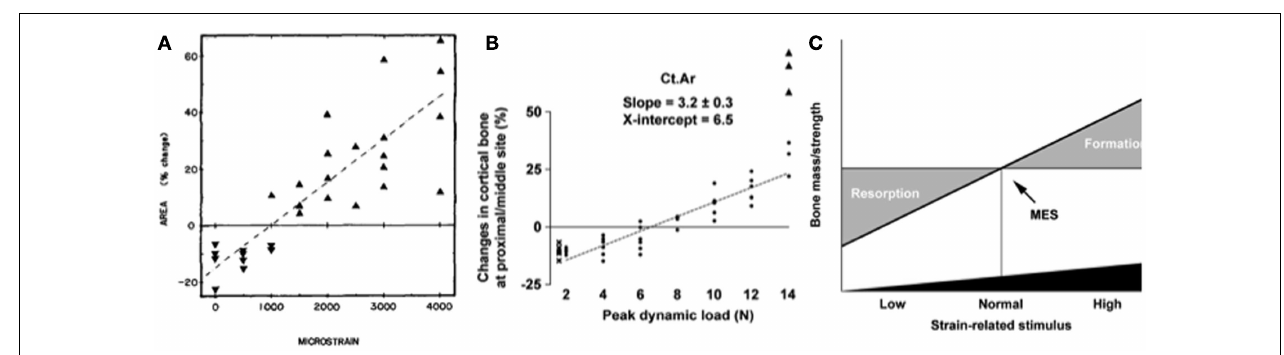
FIGURE 6 |The “lazy zone” is an artifact associated with background mechanical strain stimuli . Increasing mechanical strain is associated with a linear increase in bone mass in studies when background strains are eliminated in the isolated avian ulna [ (A) , (91)] and combined sciatic neurectomy and tibial loading models [ (B) , (86)].This indicates there is no “lazy zone” in bone’s adaptation to loading [ (C) , (86)]. MES, minimum effective strain